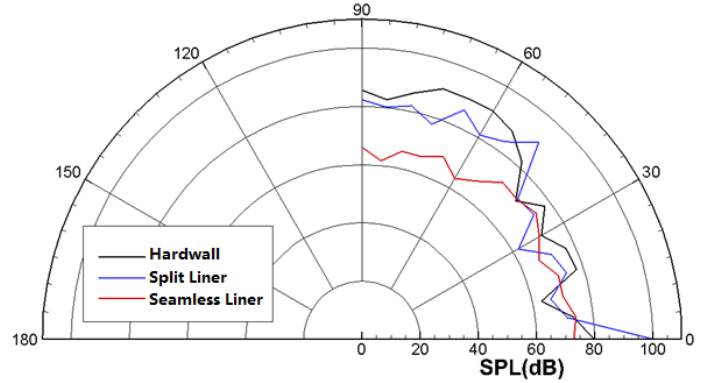
Figure 13. Acoustic directivity of (15, 0) circumferential mode at 1250 Hz.